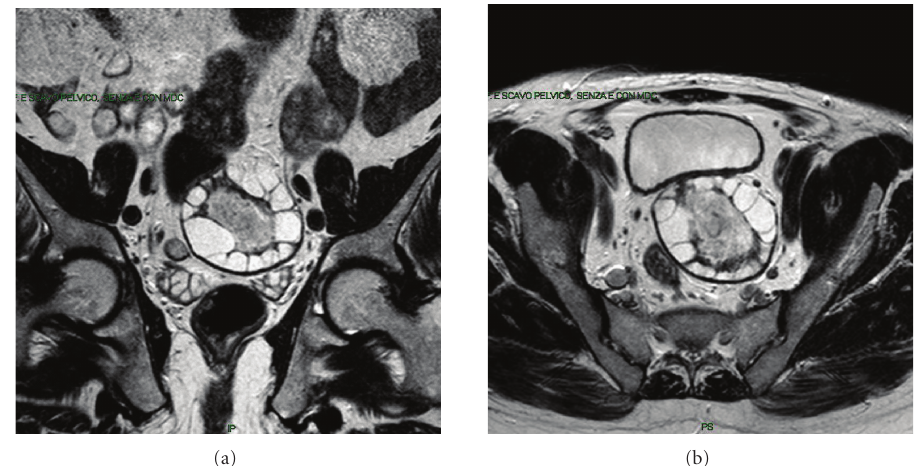
Figure 1: The MR images show the characteristic hydatid cyst in the retrovesical space, adherent to the sigmoid colon.